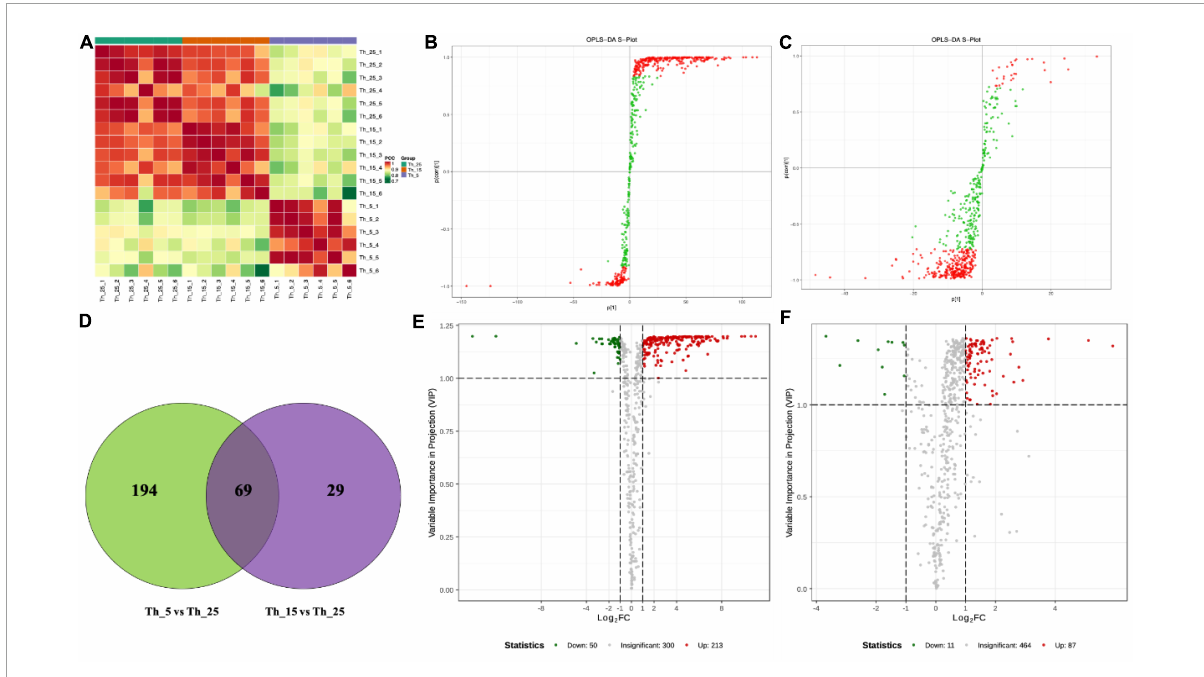
FIGURE1 Lipidomic analysis of Aurantiochytrium sp. SZU445 under low temperature. (A) Correlation between samples, (B) OPLS-DA S-plot analysis of Th_5 vs. Th_25, (C) OPLS-DA S-plot analysis of Th_15 vs. Th_25, (D) venn diagram of different metabolites in each group, (E) differential metabolites volcano map in Th_5 vs. Th_25, (F) differential metabolites volcano map in Th_15 vs. Th_25 (The samples treated with 25, 15, and 5 ◦ C were named Th_25, Th_15, and Th_5,